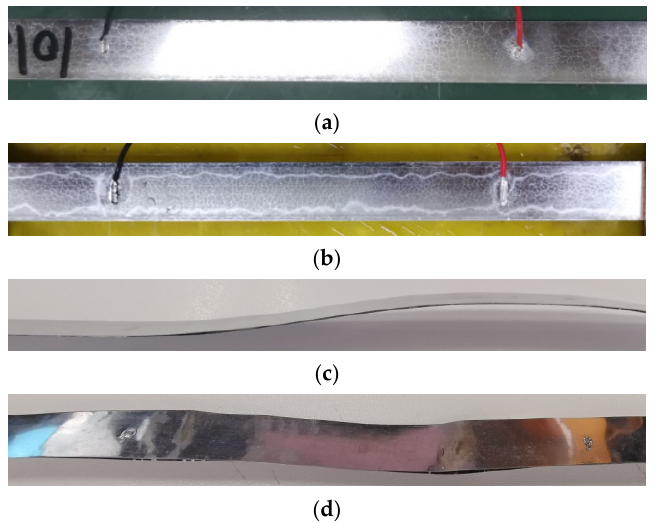
Figure 7. Surface conditions of sample 4: ( a ) before impact test; ( b ) when peak current was 3926.0 A; ( c ) when peak current was 4144.0 A; ( d ) when peak current was 4361.1 A. The key factor influencing the temperature of the HTS tape should be the Joule heat generated during the quench process, which is determined by a combination of quench resistance, current, and quench time. The variation of Joule heat Q generated in the HTS tape with time can be calculated using Equation (15), and its unit is Joule (J).